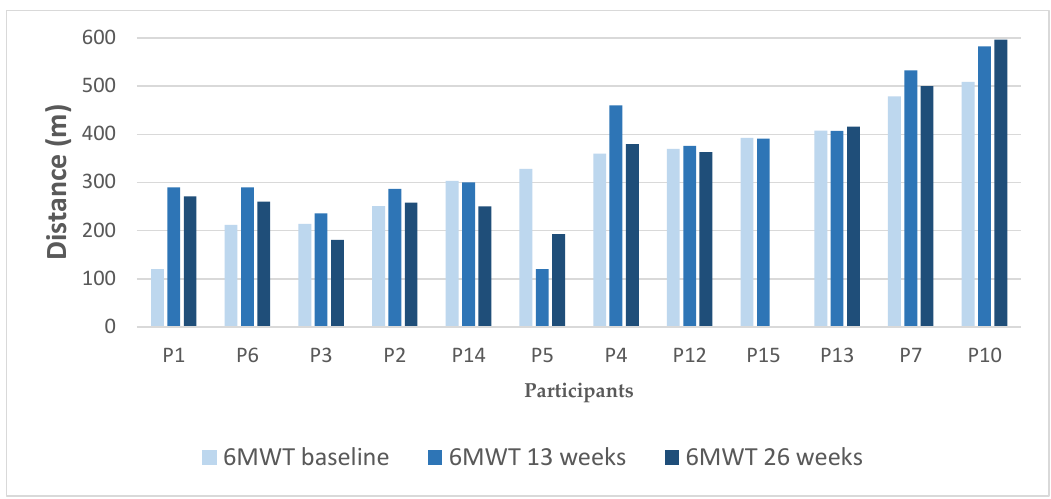
Figure 4. 6 min walking test (6MWT) results during the intervention, ordered after baseline results (from lowest to highest).